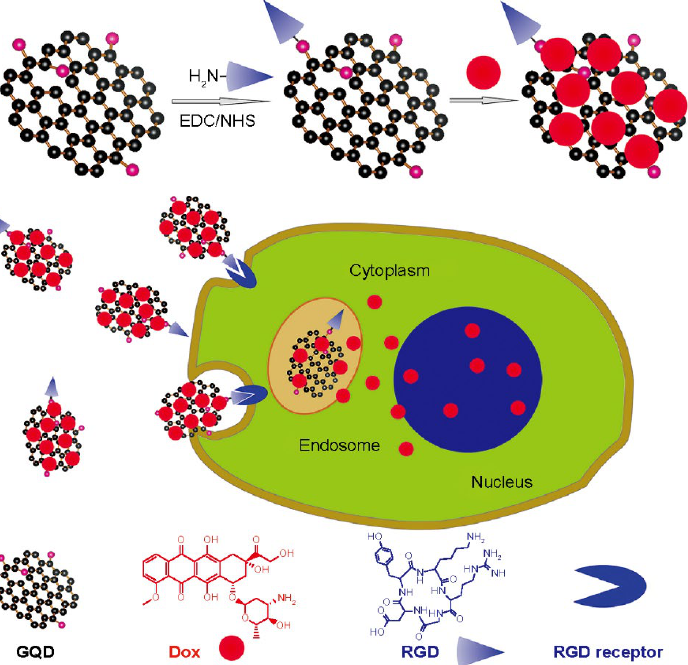
Figure 4. Schematic presentation of cancer cells being treated by multifunctional GDQs [51]. Abbreviations: eDc/Nhs, 1-(3-(dimethylamino) propyl)-3-ethyl carbodiimide and N- viations: eDc/Nhs, 1-(3-(dimethylamino) propyl)-3-ethyl carbodiimide and N-hydroxysuccinimide; hydroxysuccinimide; GQD graphene quantum dot, Dox, doxorubicin; RGD, arginine glycine- GQD graphene quantum dot, Dox, doxorubicin; RGD, arginine glycine-aspartic acid. aspartic acid. Copyright Dove Press, open access to scientific and medical research.